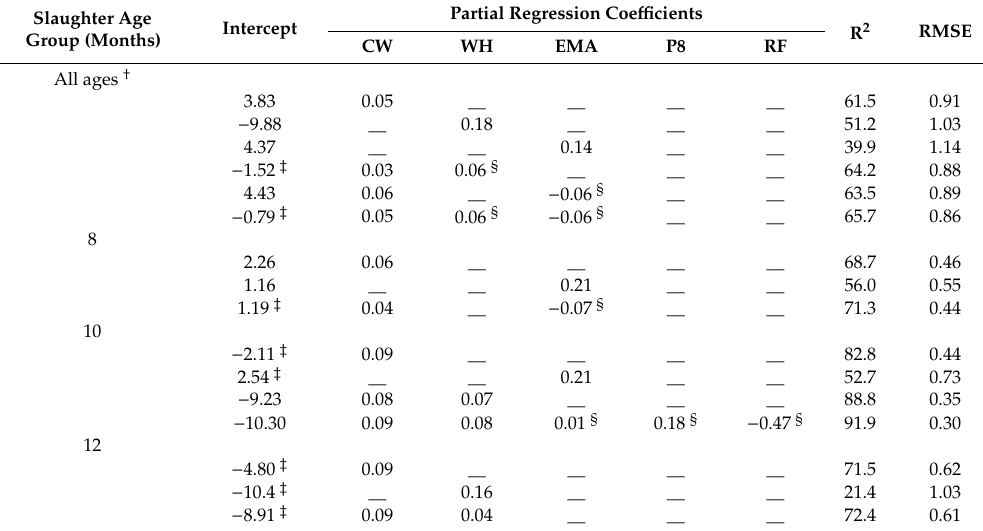
Table 3. Linear models for hind-leg muscles weight using carcass weight (CW, kg), wither height (WH, cm), eye muscle area (EMA, cm 2 ), rump fat depth (P8, mm), and rib fat depth (RF, mm) for the combined steer data and within slaughter age